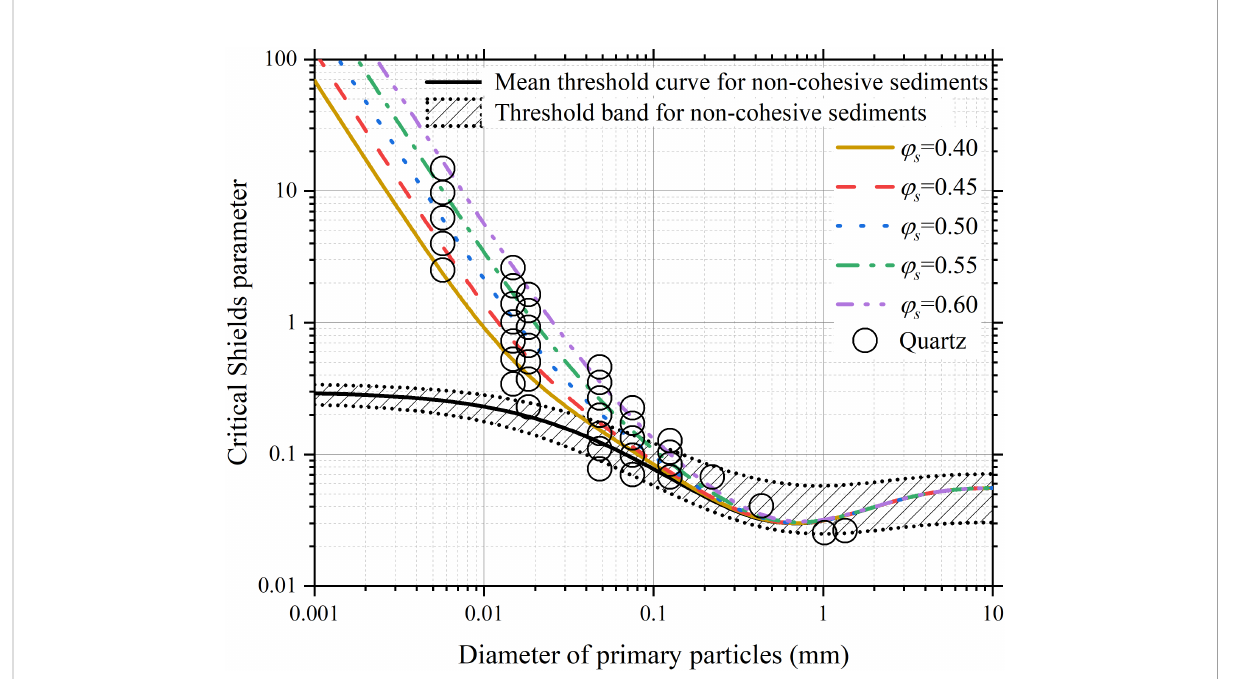
FIGURE 11 The critical Shields parameter predicted by Eq. (30) varying with the diameter of primary particles and solid volume fraction and being compared with the critical Shields parameters of quartz of different particle diameters measured by Roberts et al.